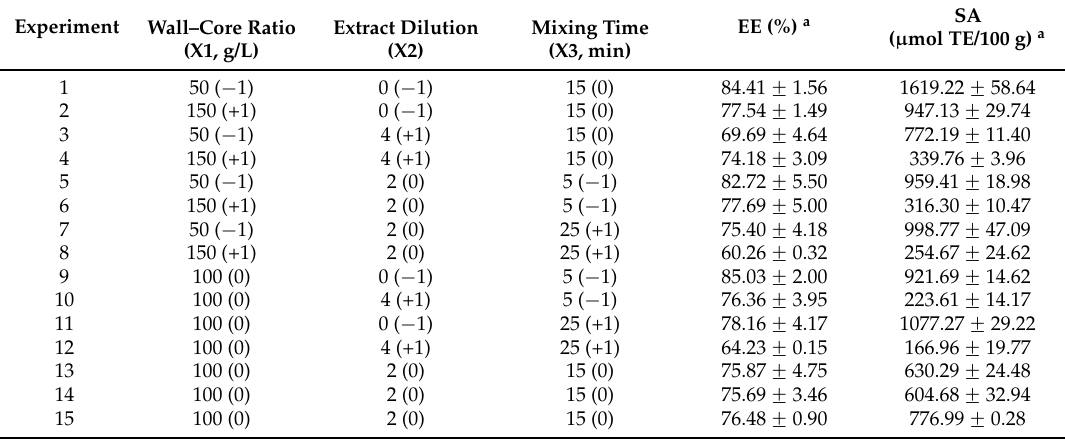
Table 2. Experimental design, encapsulation efficiency and scavenging activity of encapsulates.